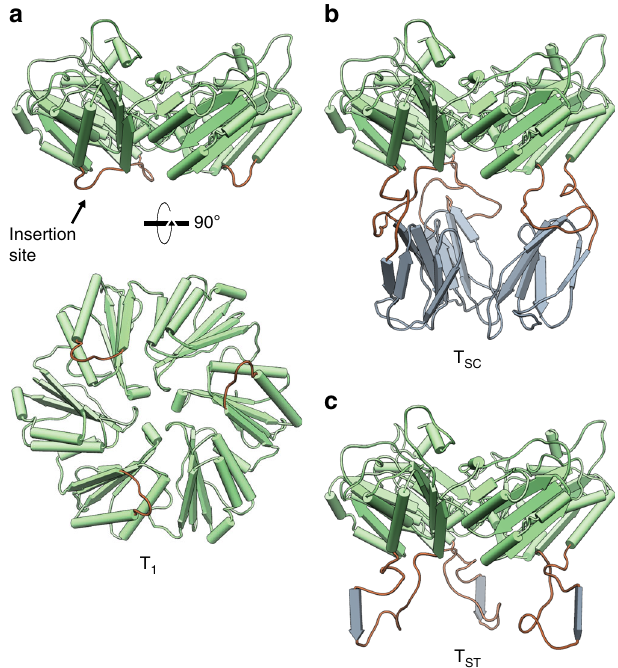
Fig. 3 Molecular models of T 1 , T SC and T ST subunits. a Model of T 1 (wt) (PDB: 5DIH) as viewed from side of shell (top) and lumen (bottom). b and c Models of T SC and T ST (respectively) viewed from the side. Flexible coil regions colored in brown; SpyCatcher and SpyTag regions colored in